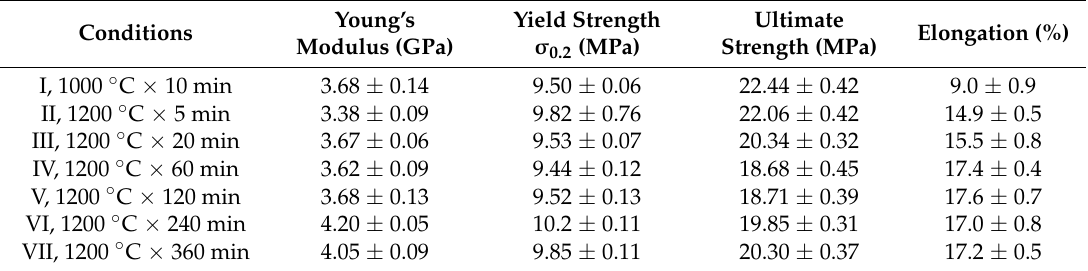
Table 2. Tensile property of 316L SSFFs